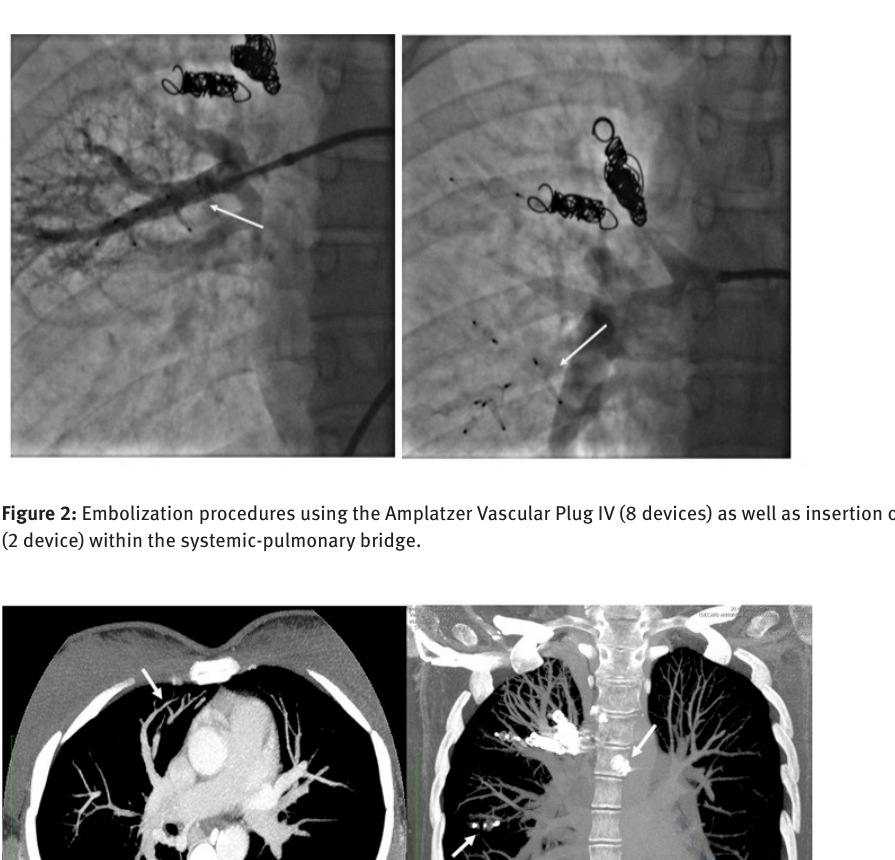
Figure 1: Thoracic angio-CT scan at admission shows: presence of multiple AV Fistulas of RUL and RLL, increase of pulmonary venous and right bronchial artery and its branches caliber associated to aneurismatic dilatation of 1 cm. Web-like appearances are evident in the superior segment of RUL. Transversal (a) and Coronal (b) view.